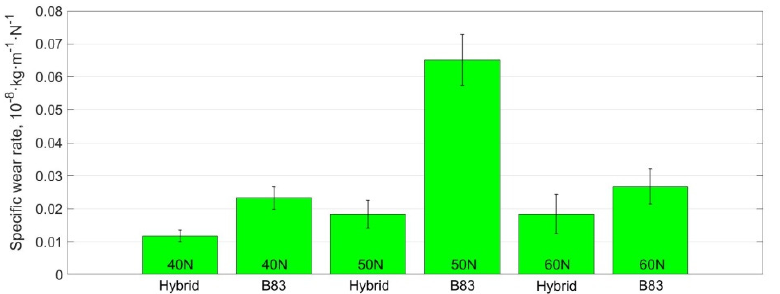
Figure 7. Specific wear rate of the hybrid material and B83 babbitt with respect to different loads of 40, 50, and 60 N and a distance of 418 m under dry friction conditions at room temperature.